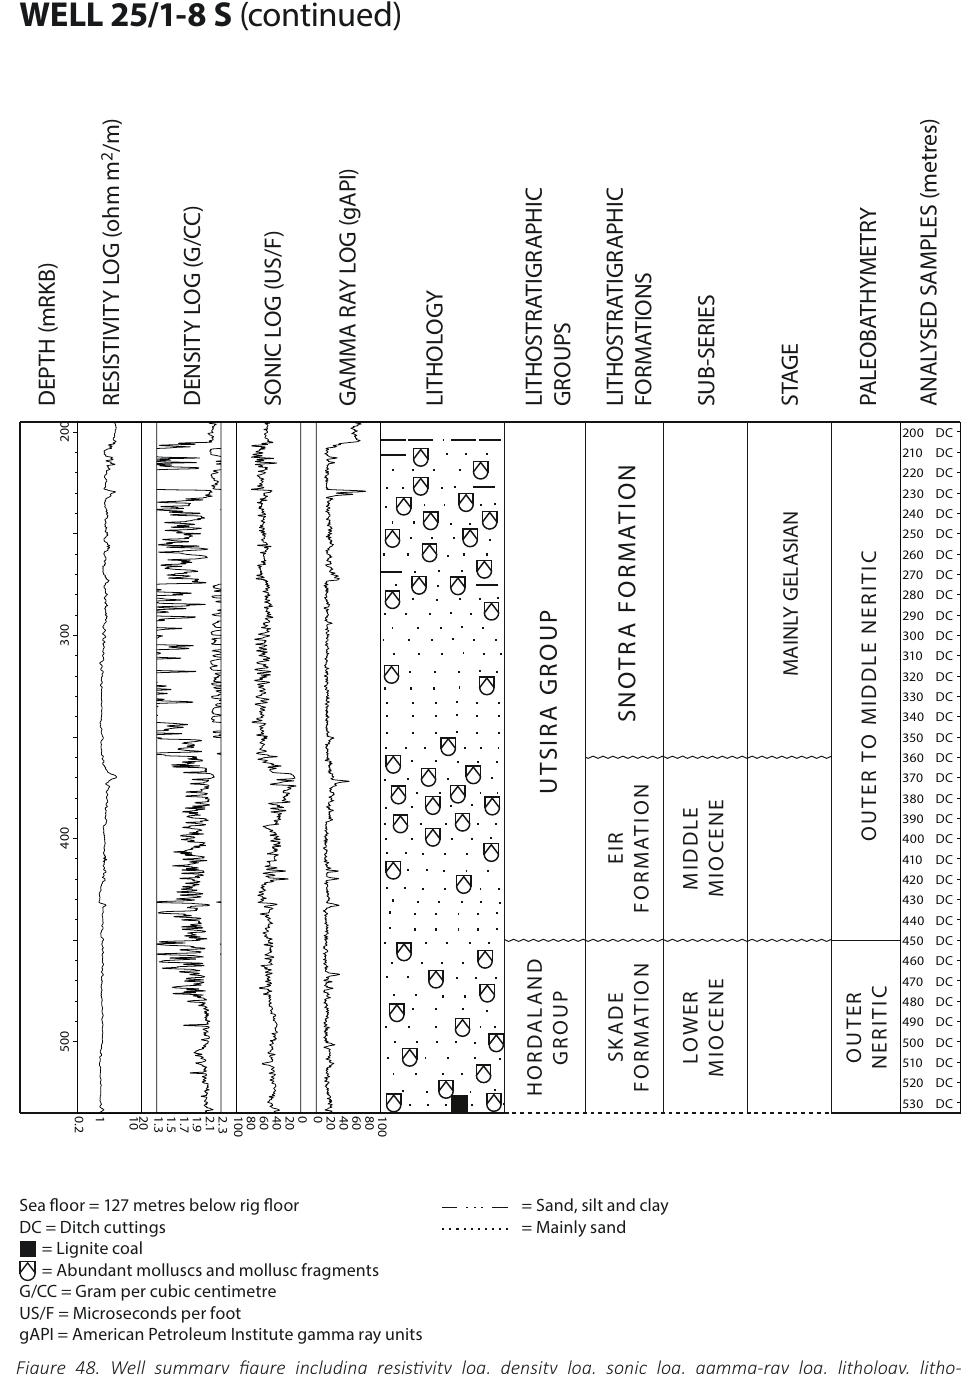
Figure 48. Well summary figure including resistivity log, density log, sonic log, gamma-ray log, lithology, litho- stratigraphic units, sub-series, stage, paleobathymetry and analysed samples for the upper part of the investigated sequence in well 25/1–8 S (lower Miocene to Gelasian; modified after Eidvin et al.,